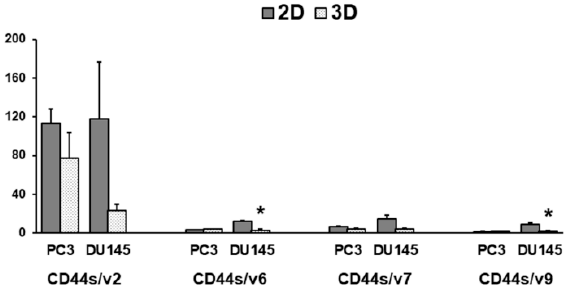
Figure 9. CD44s/CD44 variant in PC3 and DU145 cells. Bar graphs showing the CD44s/CD44 variant in PC3 and DU145 cells grown in 2D-monolayers and 3D cell cultures. Data are means ± SD of duplicate samples. * p < 0.05 vs 2D-monolayer.